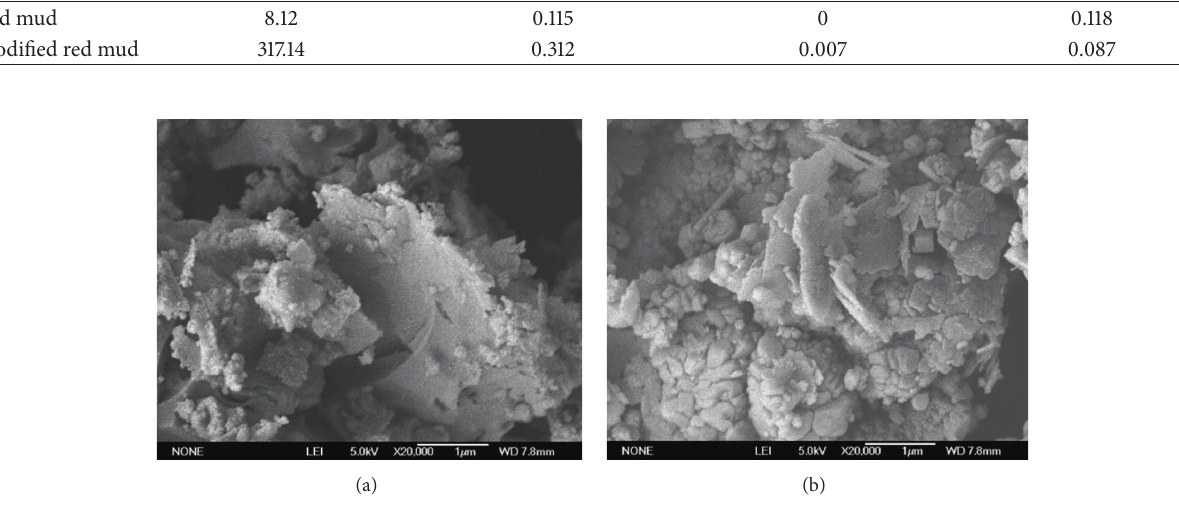
Figure 2: SEM images of red mud (a) and modified red mud (b).